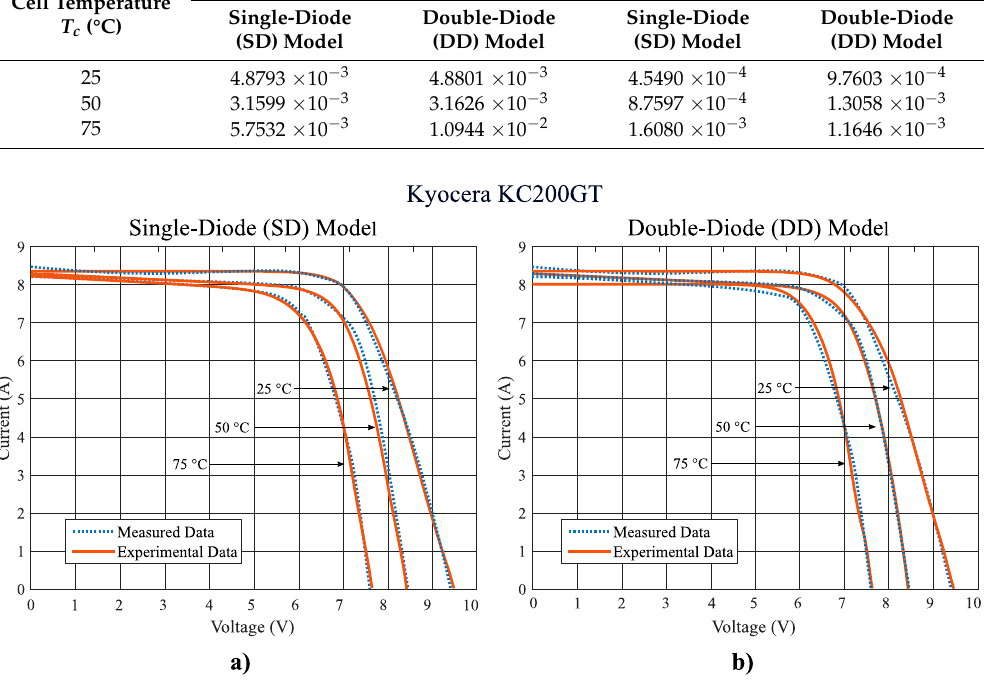
Figure 10. Estimated I-V characteristics curves at different cell temperatures (25, 50 and 75 ◦ C) and fixed solar irradiance ( G = 1000 W/m 2 ) for an individual cell from a Kyocera KC200GT Solar Panel. ( a ) SD model and ( b ) DD model.